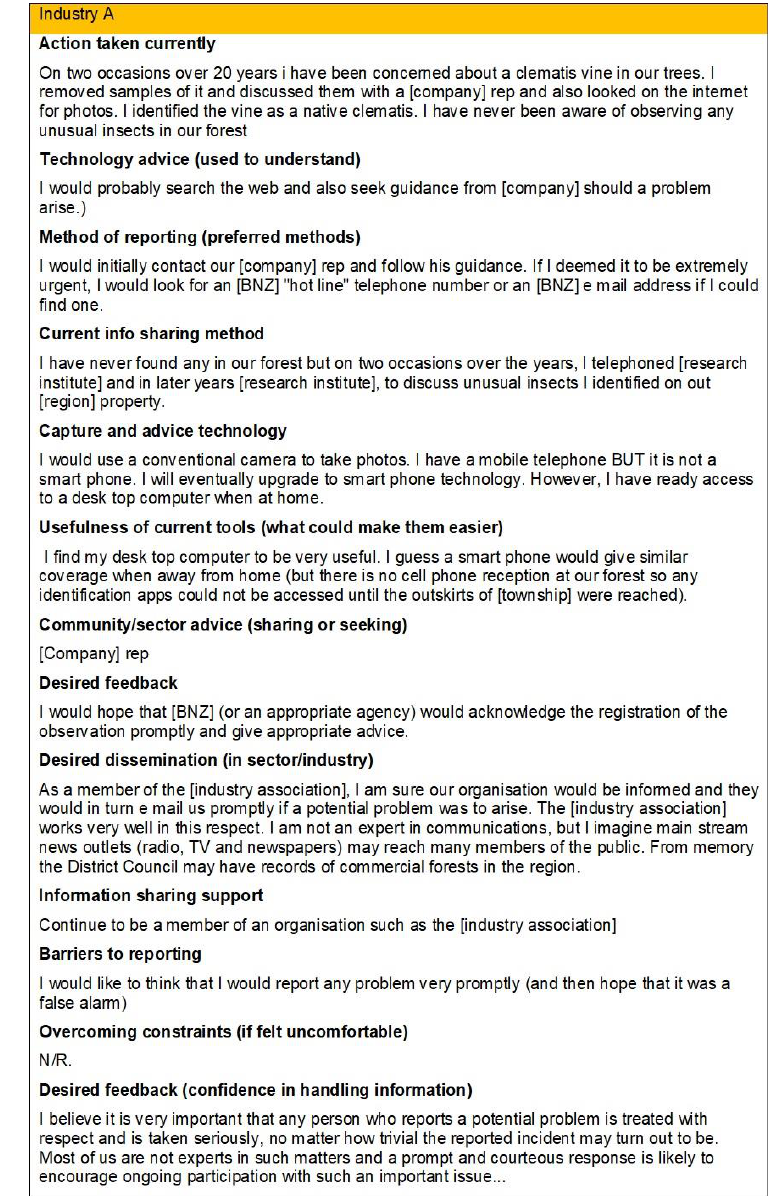
Figure A3. Sample mental model 3.